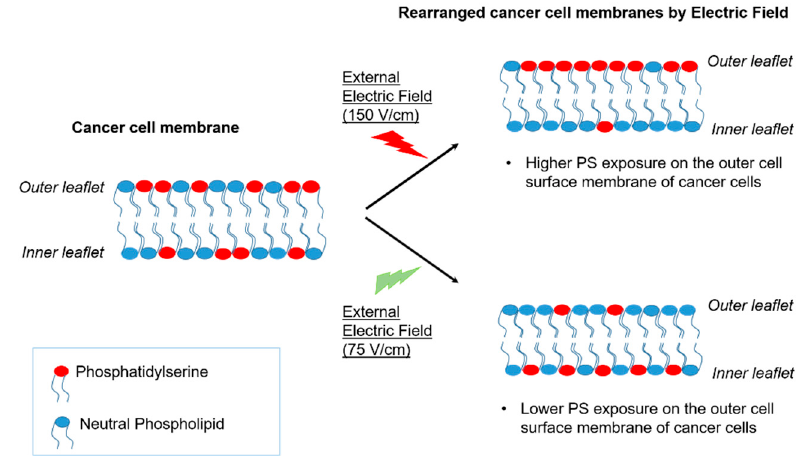
Figure 5. Schematic representation of phosphatidylserine (PS) modulation in cancer cells via external electric field .